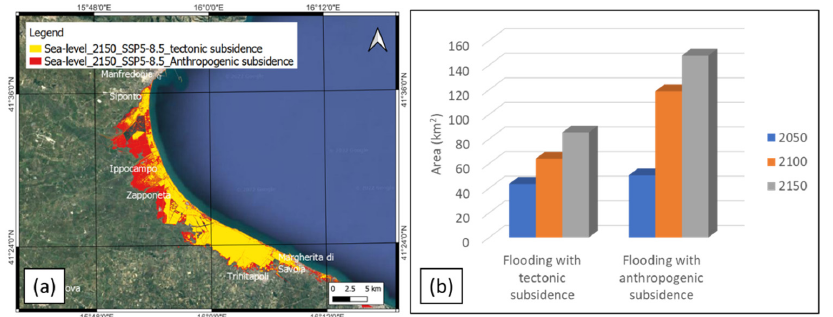
Figure 6. Comparison of relative sea-level-rise scenarios for tectonic and anthropogenic contributions of land subsidence: ( a ) flooding surface with tectonic subsidence (yellow color) and with anthropogenic subsidence (red color); ( b ) histograms of multitemporal (2050, 2100, 2150) flooding area as a function of the tectonic and anthropogenic subsidence.